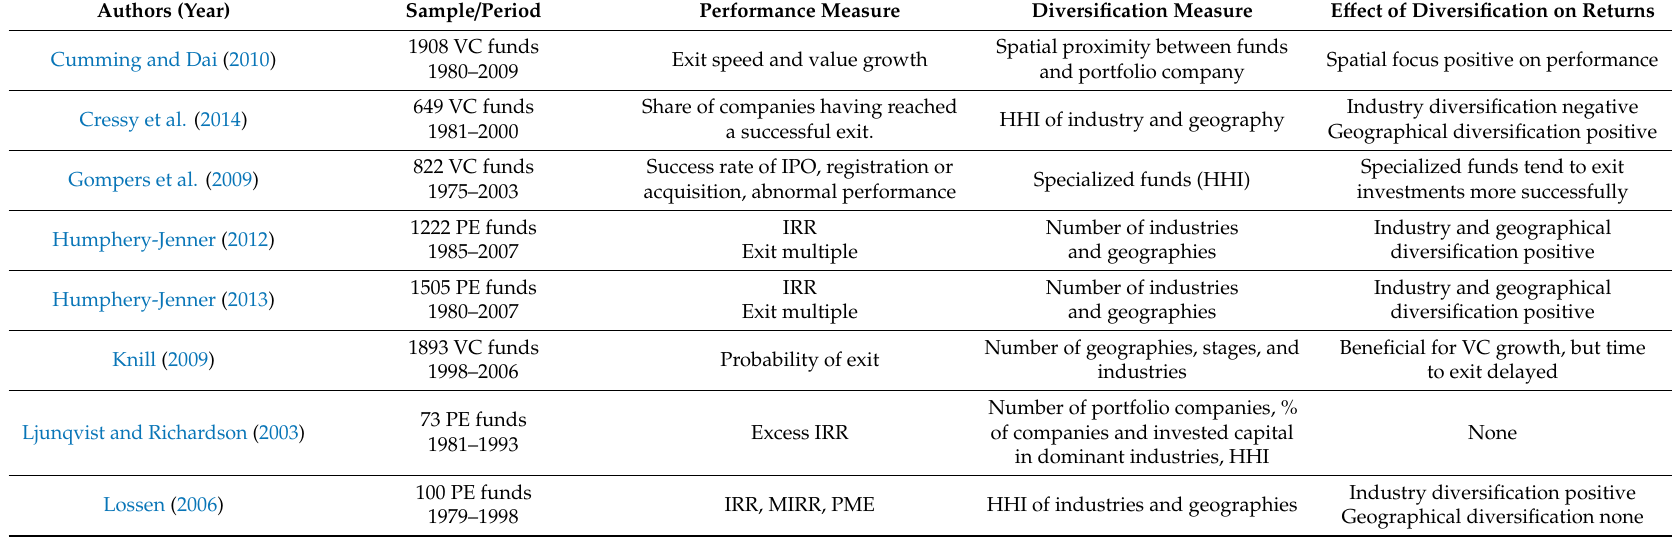
Table A1. Summary of studies on the relationship between diversification and private equity fund performance.